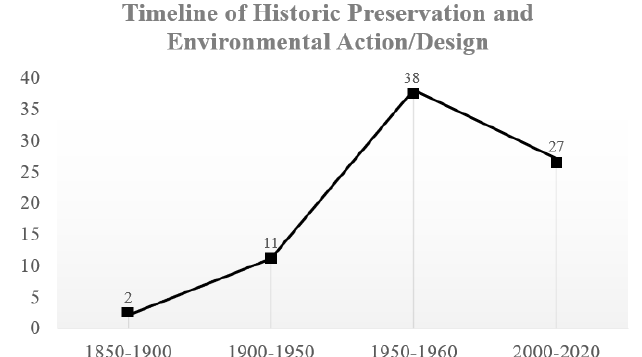
Fig. 1. Number of conferences on sustainability by years [Created by the authors based on 8,